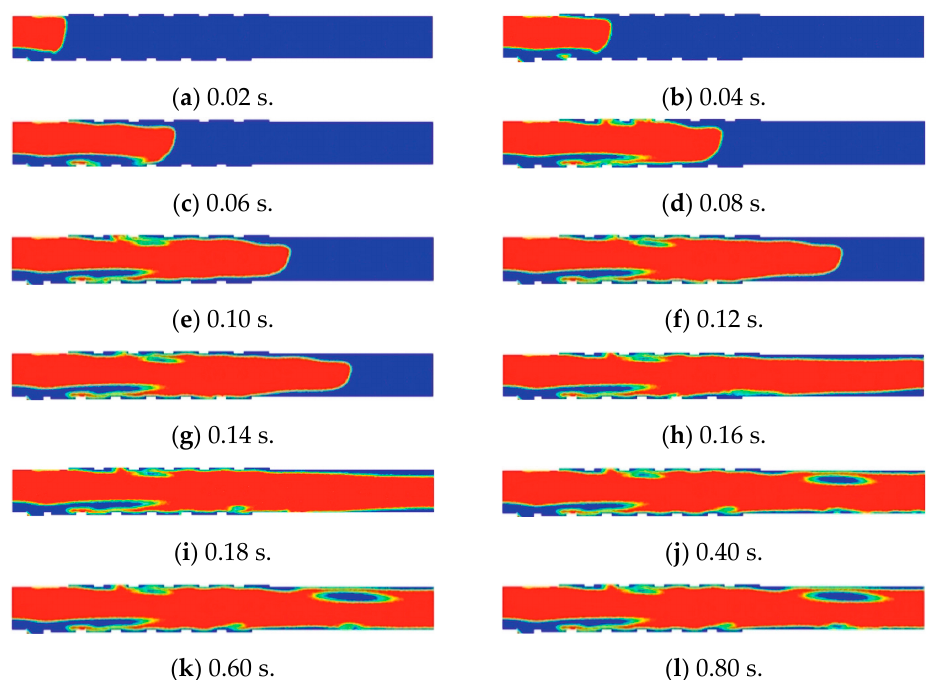
Figure 3. Development of CAF [25]. (Red for oil and blue for water.)